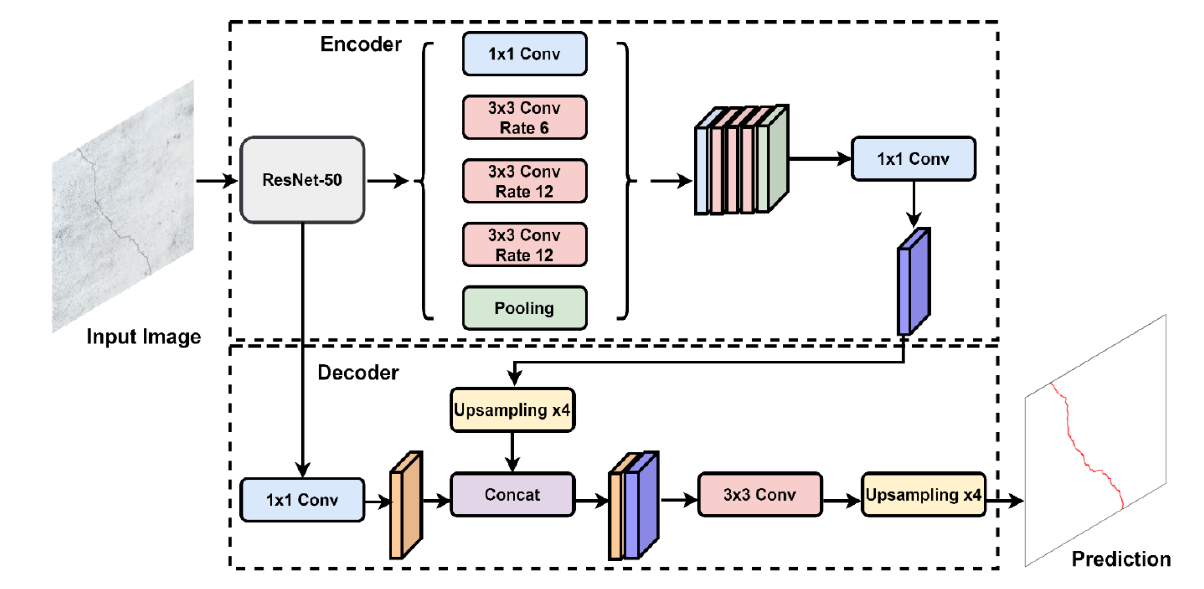
Figure 7. Overall architecture of DeepLabV3+ (Backbone Network = ResNet-50).